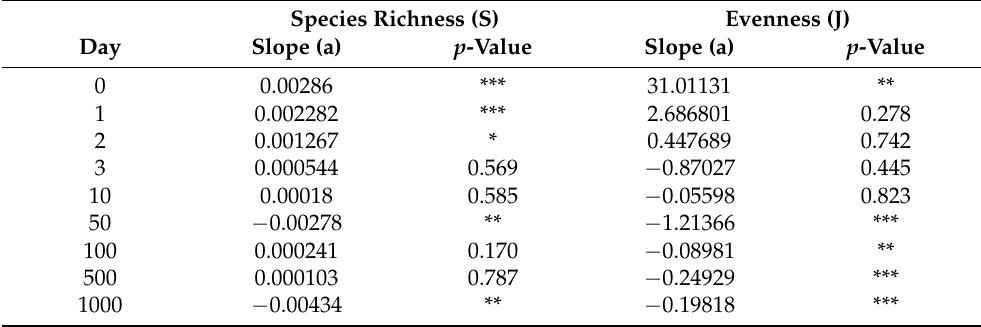
Note: *** < 0.001, ** < 0.01, * < 0.05.